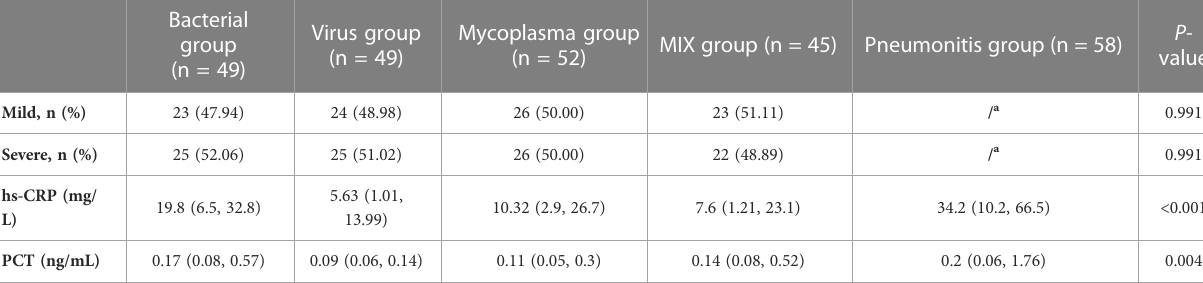
TABLE 2 Differences between groups of pneumonia due to different